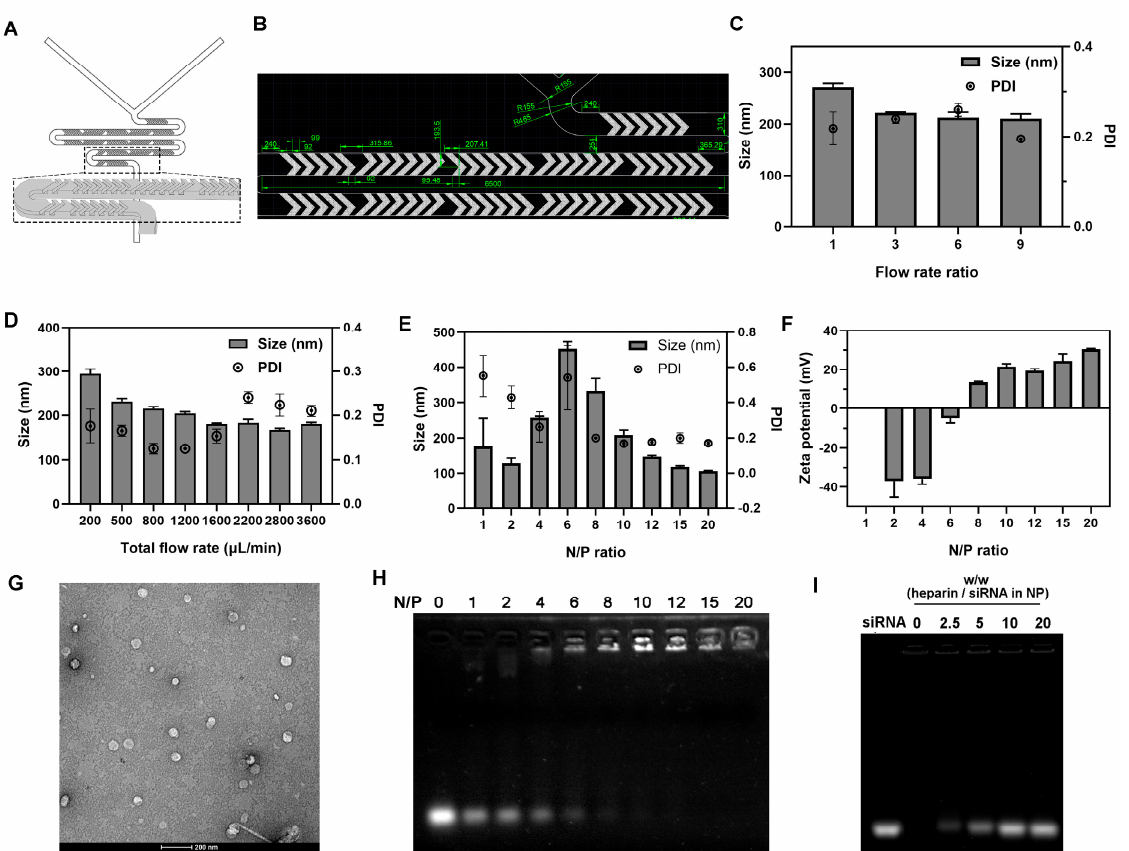
Figure 1. Characterization of Chol-es-Lys/siRNA nanocomplexes. ( A ) The structure and ( B ) the mi- croscopic size of the staggered herringbone micromixer chip. The optimization process of ( C ) flow rate ratio and ( D ) total flow rate as microfluidics parameters. ( E ) Particle size and ( F ) surface charge of microfluidic-based Chol-es-Lys/siRNA nanocomplexes at different N/P ratios. ( G ) Morphology of Chol-es-Lys/siRNA nanocomplexes (N/P = 15) by transmission electron microscope. ( H ) siRNA binding affinity for Chol-es-Lys under various N/P ratio. ( I ) Heparin displacement assay of Chol- es-Lys/siRNA nanocomplexes at N/P = 15. PDI, polydispersity index; NP, referred to Chol-es- Lys/siRNA nanocomplexes.